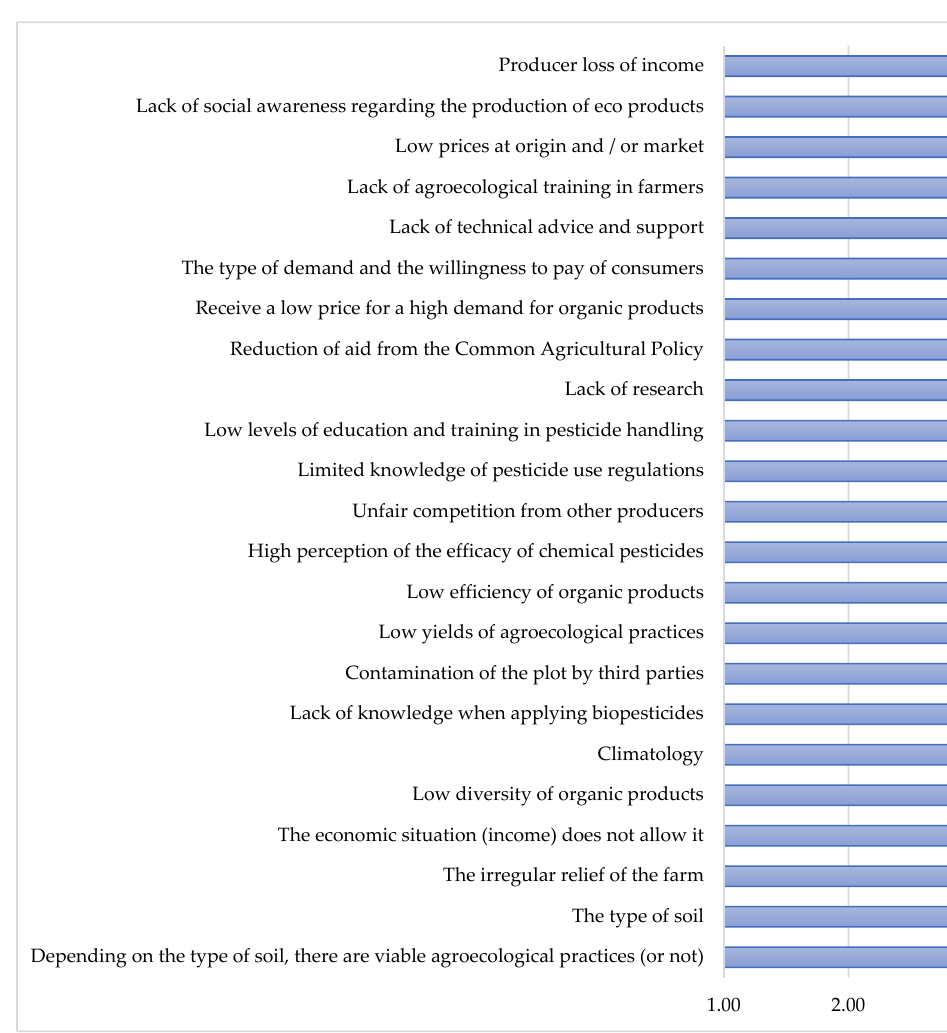
Figure 5. Average according to the different barriers when adopting (or not) agroecological